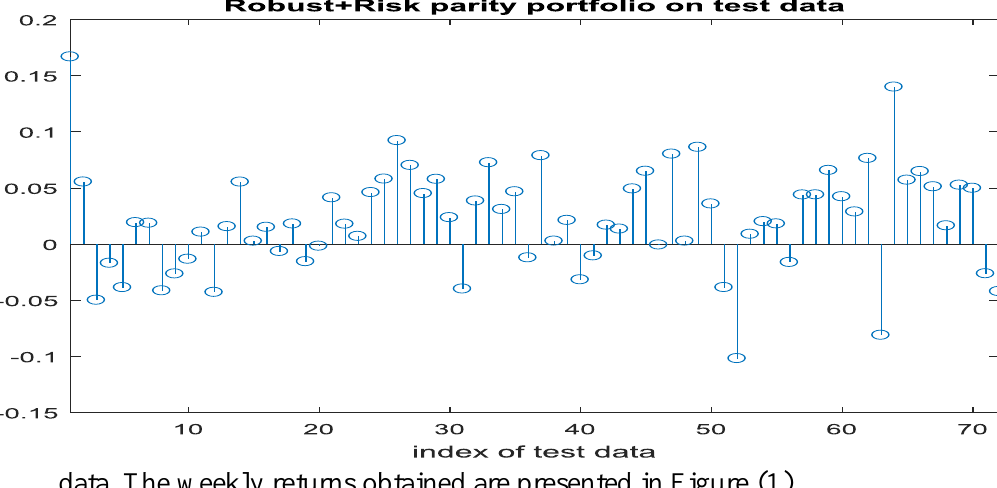
Figure 1. Returns from the model of relative robust risk parity on test data